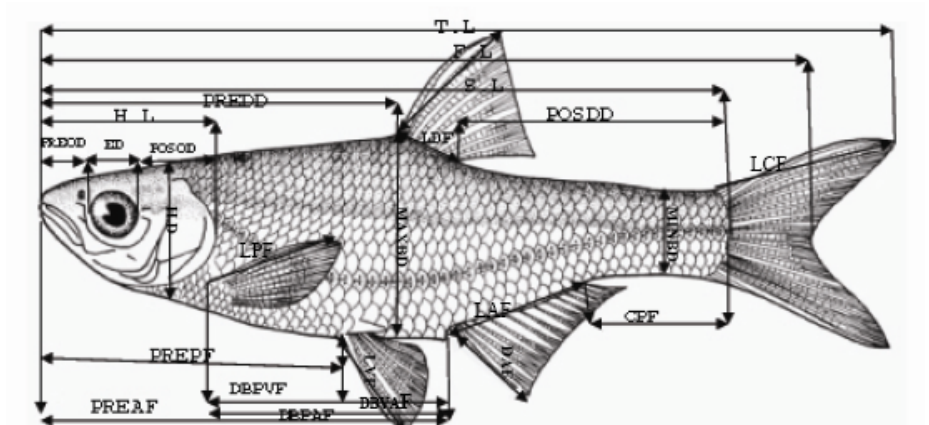
F IGURE 2. Morphometric characters measured in Alburnoides qanati. Total length (tl), fork length (fl), standard length (sl), head length (hl), head depth (hd), head width (hw), preorbital distance (preod), postorbital distance (posod), interorbital distance (inord), eye diameter (ed), predorsal distance (predd), postdorsal distance (posdd), length of dorsal fin (ldf), depth of dorsal fin (ddf), length of anal fin (laf), depth of anal fin (daf), preanal fin (pread), length of pectoral fin (lpf), length of pelvic fin (lvf), prepelvic length (prevfd), maximum body depth (maxbd), minimum body depth (minbd), distance between pectoral fin and anal fin (dbpaf), distance between pectoral fin and pelvic fin (dbpvf), distance between pelvic fin and anal fin (dbvaf), length of caudal fin (lcf), length of